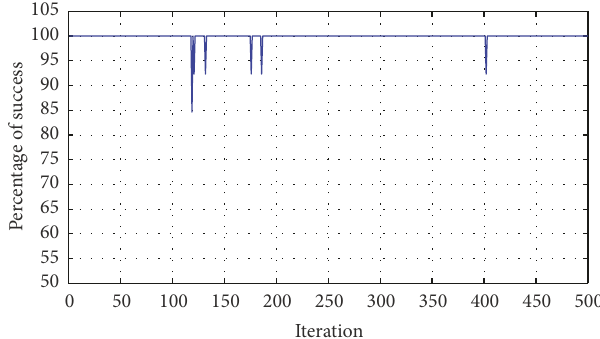
Figure 7: Simulation result on the learning of the approach with increased demand.